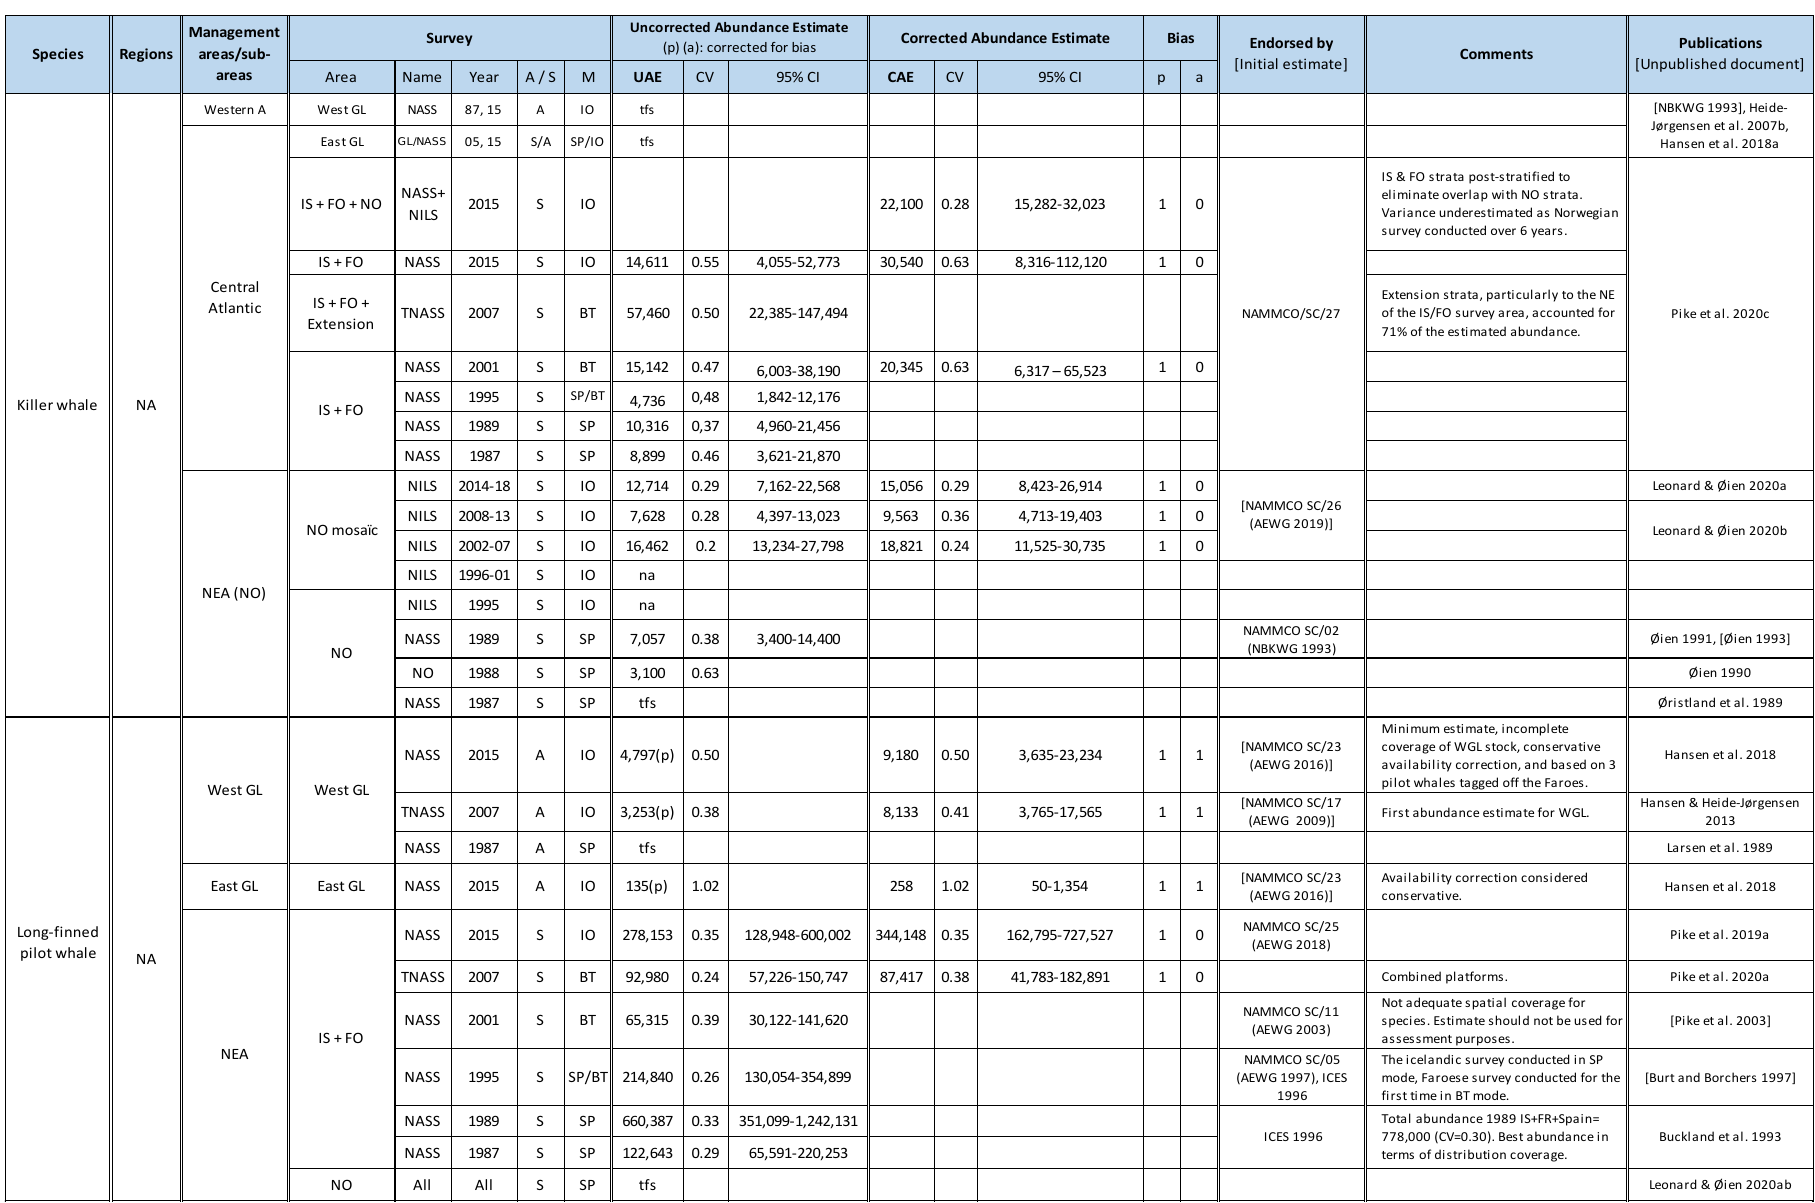
IS & FO strata post-stratified to eliminate overlap with NO strata. Variance underestimated as Norwegian survey conducted over 6 years.